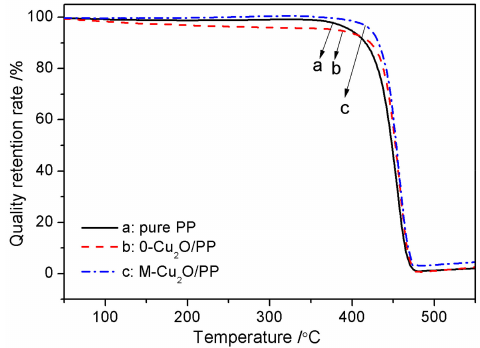
Figure 7. TGA of the Cu 2 O / PP composite.